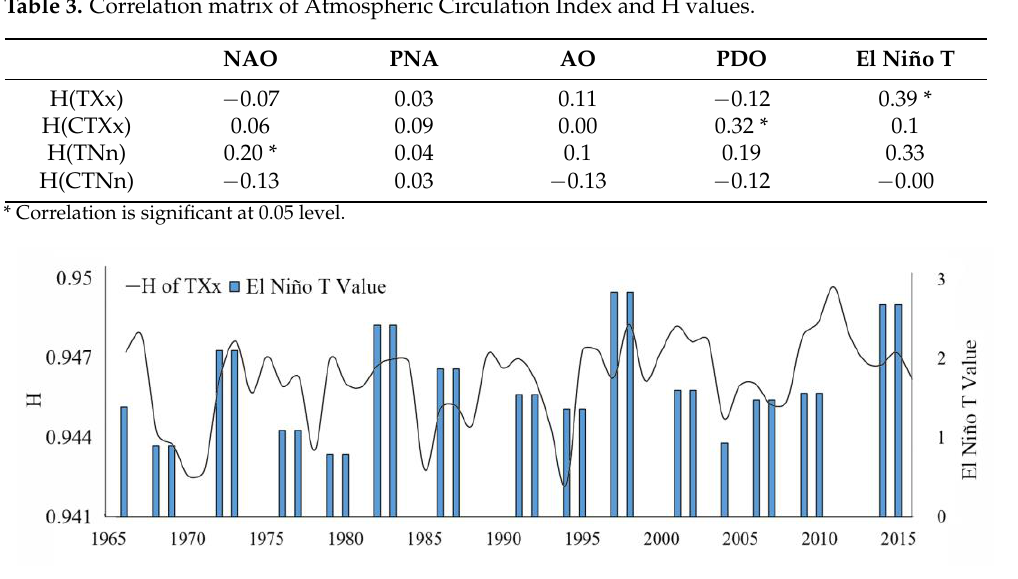
Figure 15. Temporal variation of H(TXx) and El Niño T value in China, 1966 – 2015.